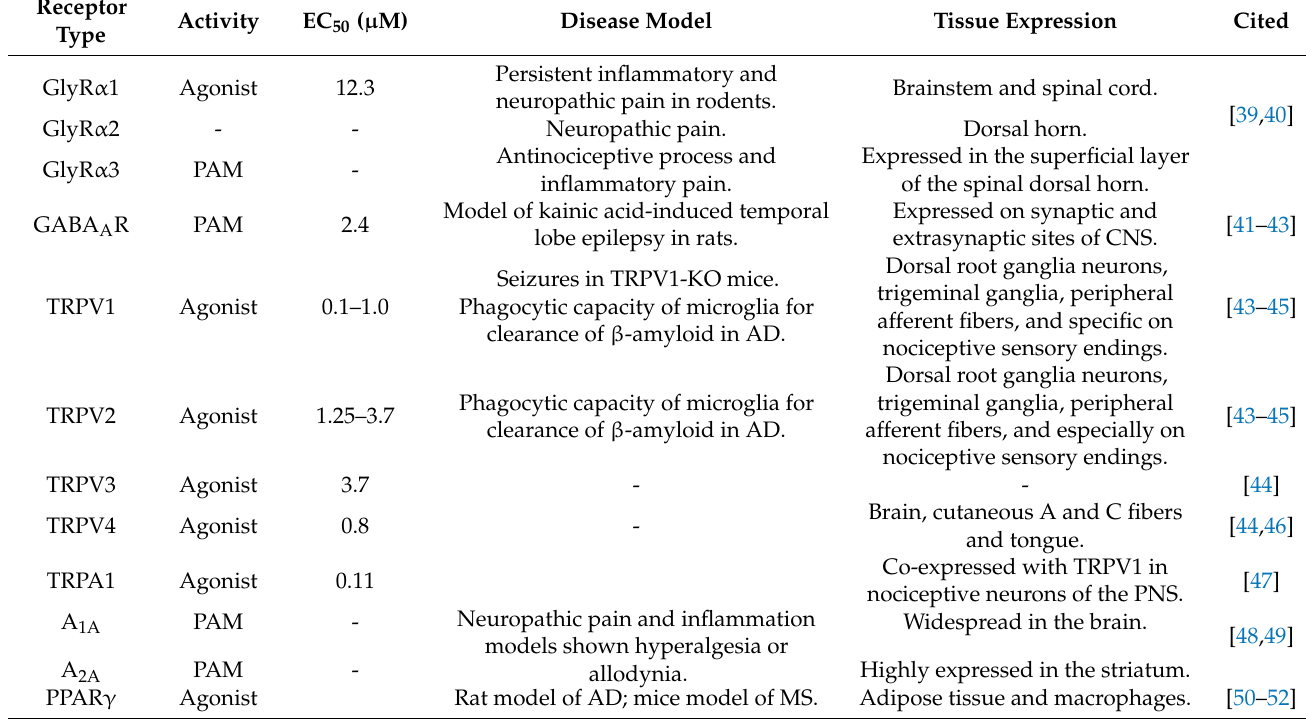
Table 2. CBD such as an agonist or PAM of receptors in the nervous